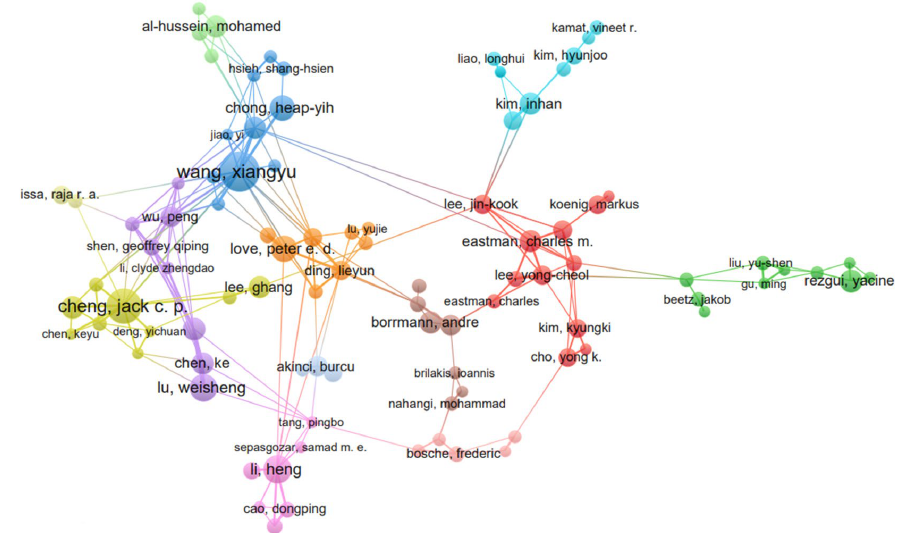
Figure 3. Collaboration relationship analysis network of authors Table 2. Top 10 countries with the greatest number of published articles